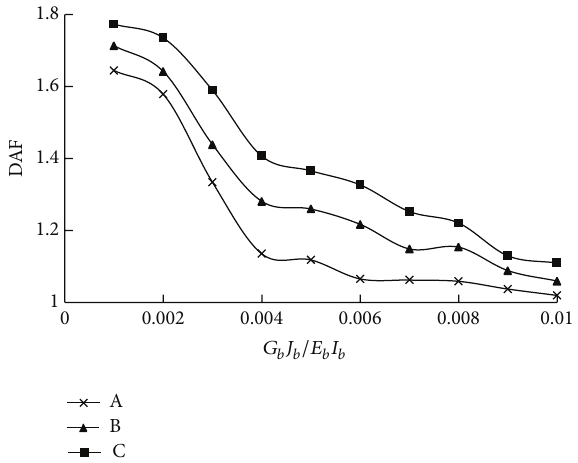
Figure 26: Dynamic amplification factor (DAF) with the ratio of bridge torsional rigidity to flexural rigidity (𝐺 𝑏 𝐽 𝑏 /𝐸 𝑏 𝐼 𝑏 ) for different vehicle flexural rigidity. (A) 𝐸 V 𝐼 V = 5.3 × 10 6 N-m 2 , (B) 𝐸 V 𝐼 V = 6.4 × 𝐼 = 8.2 × 10 10 N-m 2 10 7 N-m 2 , and (C) 𝐸 V V